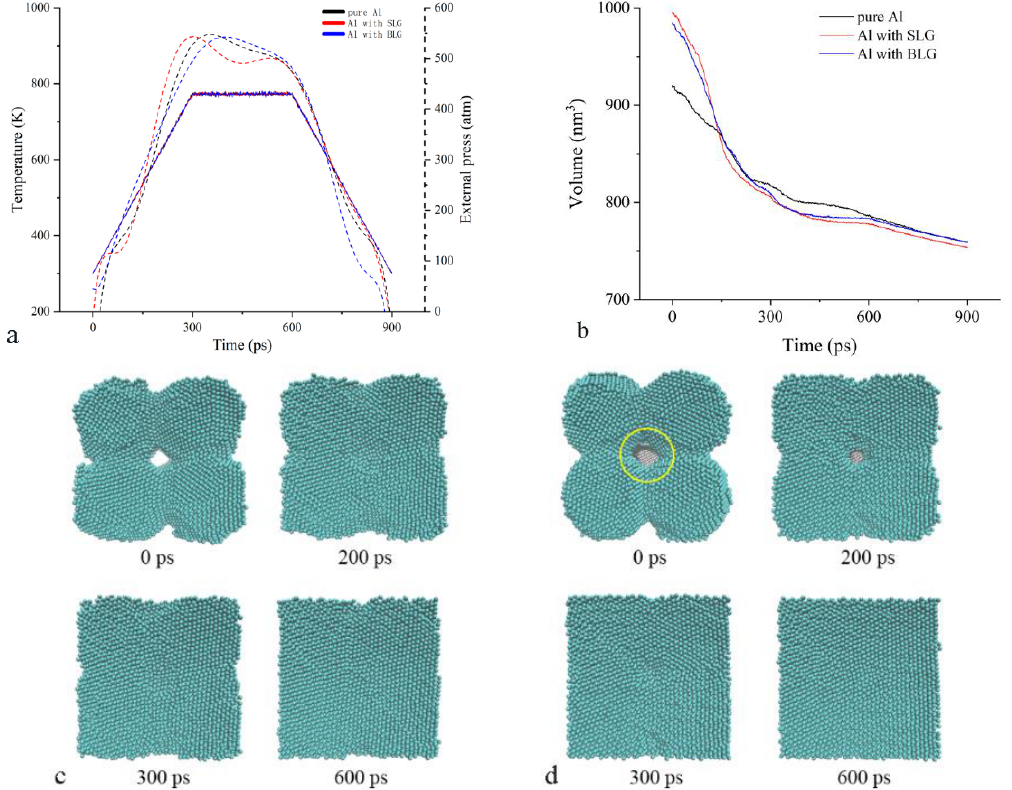
Figure 2. The changes in the sintering process. ( a ) The system volume; ( b ) the system temperature and pressure; and atomic configurations of the pure Al model ( c ) and Al-SLG model ( d ) at different sintering times.